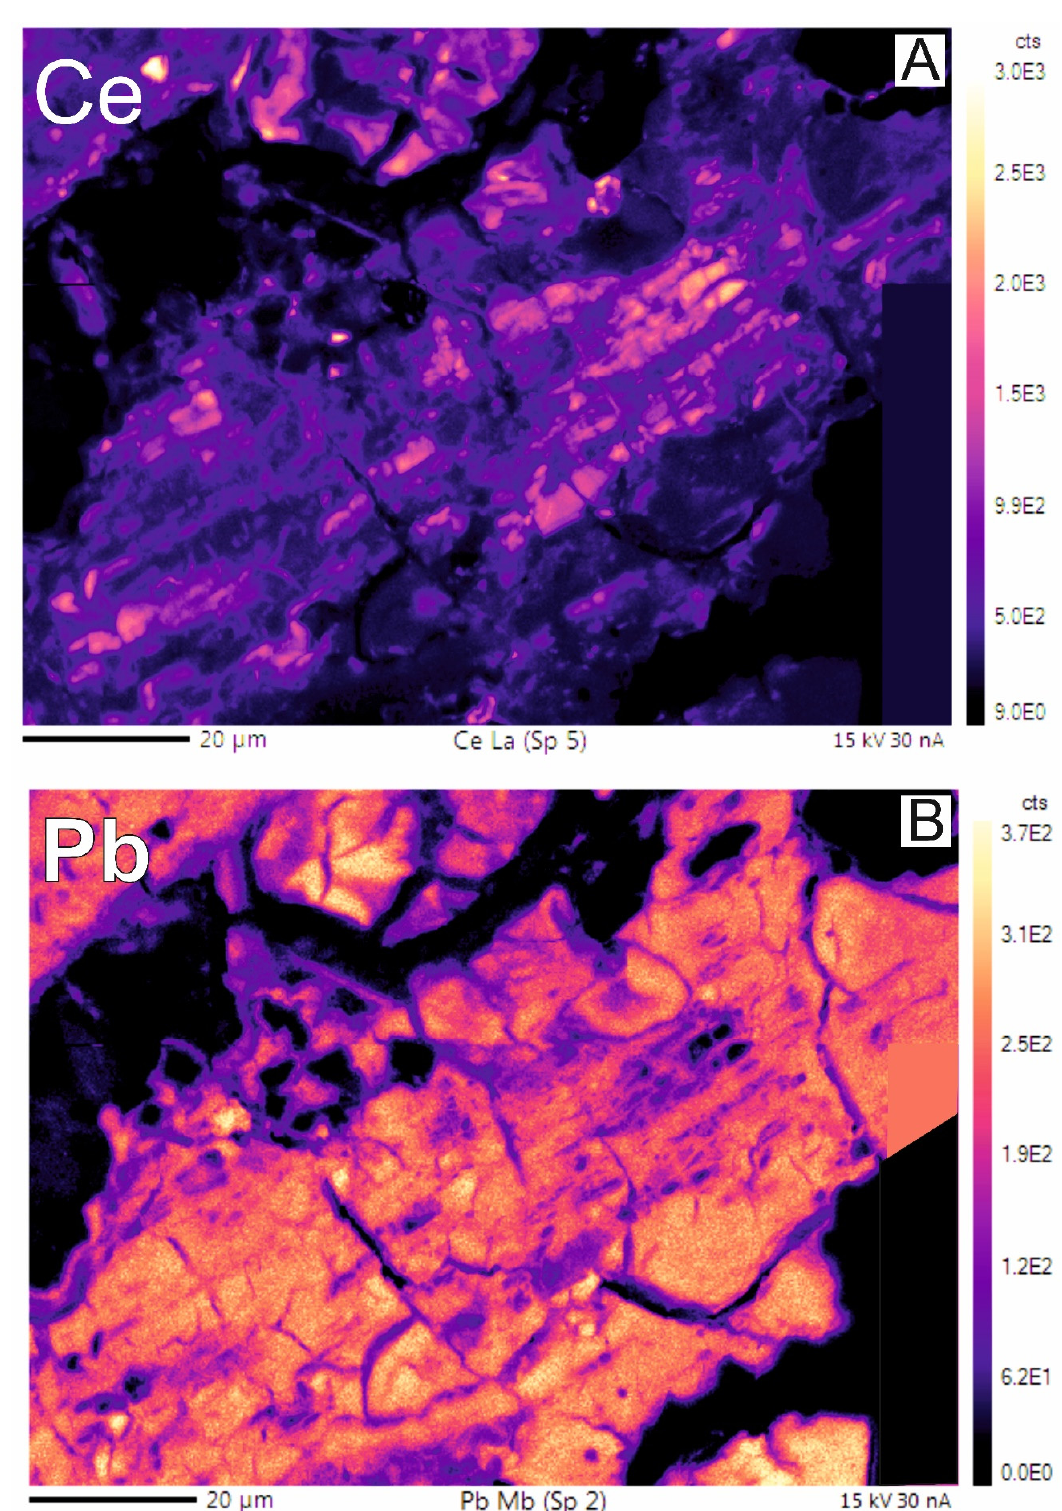
Figure 5. Chemical maps to show the antipathetic distribution of ( A ) Ce and ( B ) Pb.